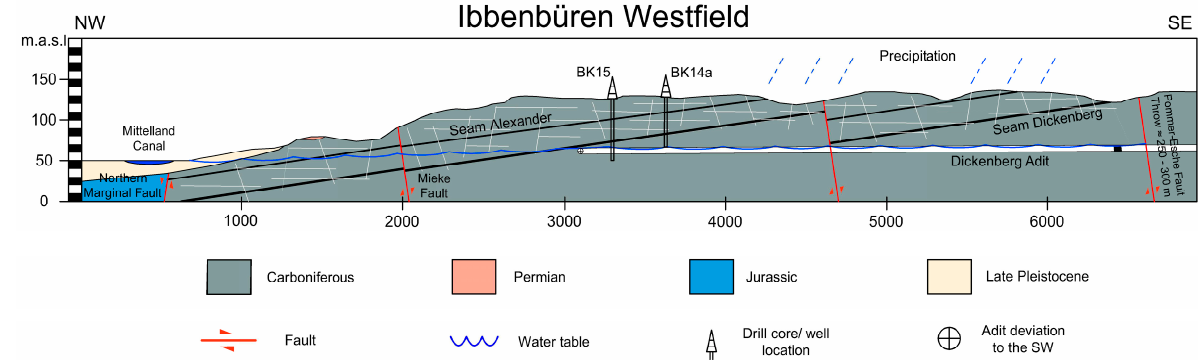
Figure 2. Geological cross-section of the Ibbenbüren Westfield (cross-section line A-A’ in Figure 1). The cross-section is vertically exaggerated 5x to better detail the shallow overburden structure and current hydrogeological situation. Modified after [39].